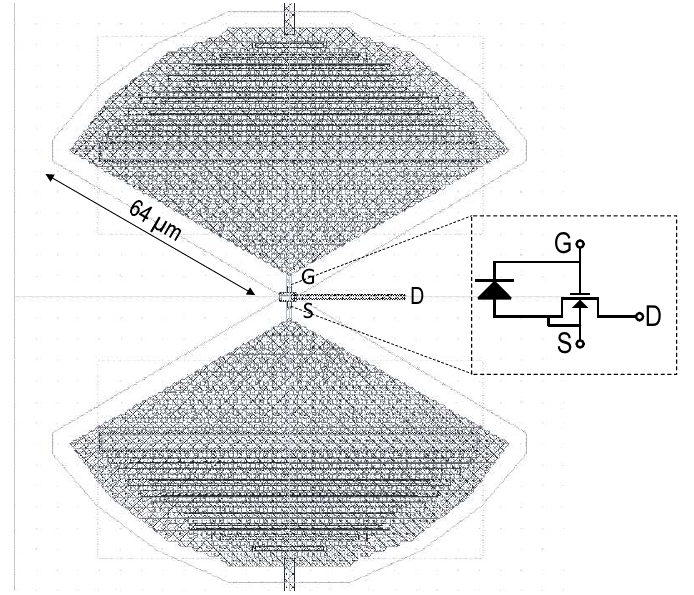
Figure 4. Layout view of the in-pixel THz antenna and MOSFET